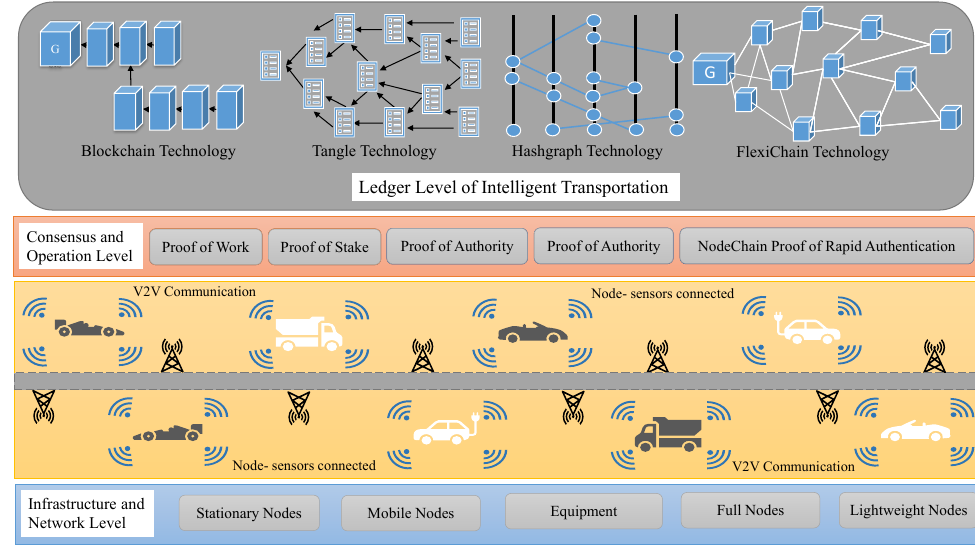
Figure 1. High-Level Depiction of DLT-Based